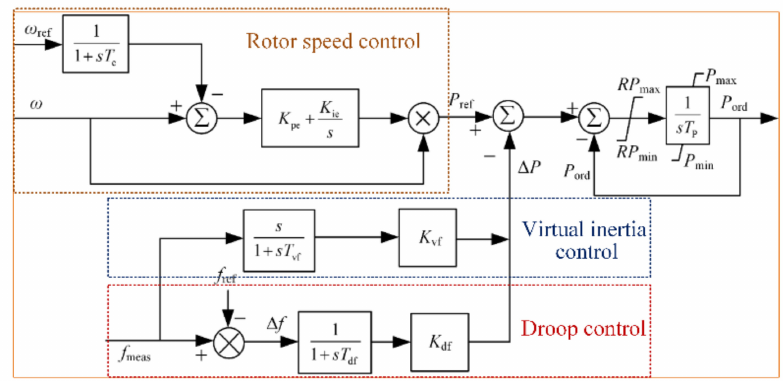
Figure 2. DFIG electrical control model contains a rotor speed control, a virtual inertia control, and a droop